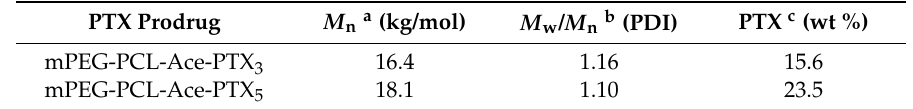
Table 1. Synthesis of mPEG-PCL-Ace-PTX.